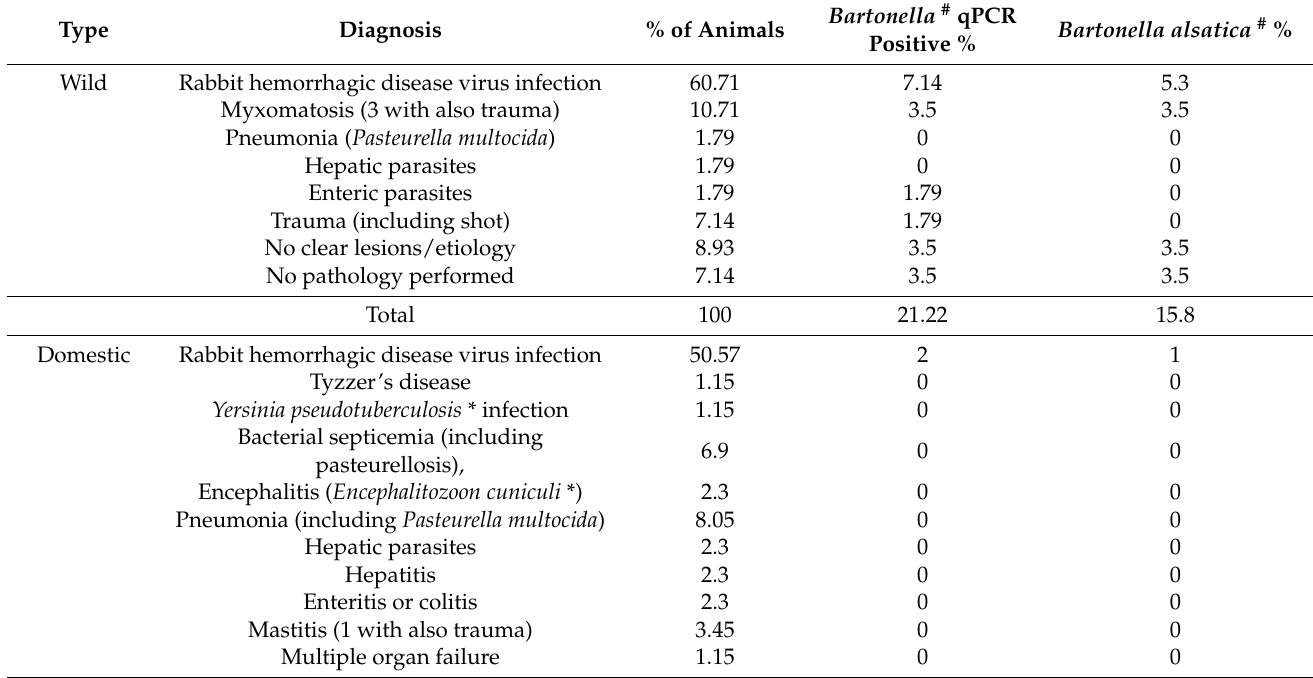
Table 1. Bartonella PCR-test results of 56 wild and 87 domestic rabbit per necropsy result.